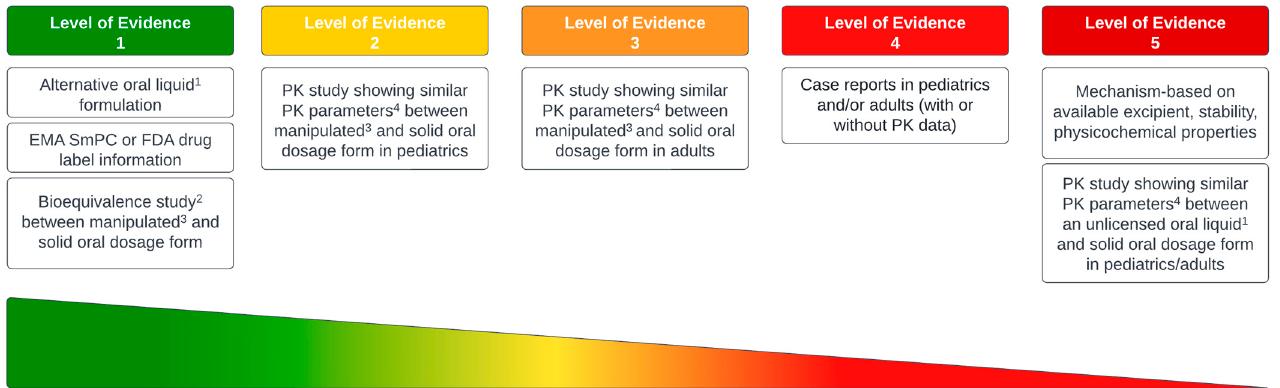
Figure 1. Category of practical recommendations according to their level of evidence. 1 oral liquid developed by the pharmaceutical company; 2 Study that follows the requirements of the EMA and/or FDA bioequivalence investigation guidelines; 3 manipulated (i.e. capsule opened, tablets crushed and/or dissolved); 4 similar PK parameters = Area Under the Curve (AUC) and maximum plasma concentration (Cmax) of the manipulated oral dosage form are within 80–125% of the PK parameters of the solid oral dosage form; EMA = European Medicines Agency; FDA = U.S. Food and Drug Administration; SmPC = summary of product characteristics; PK = pharmacokinetics.